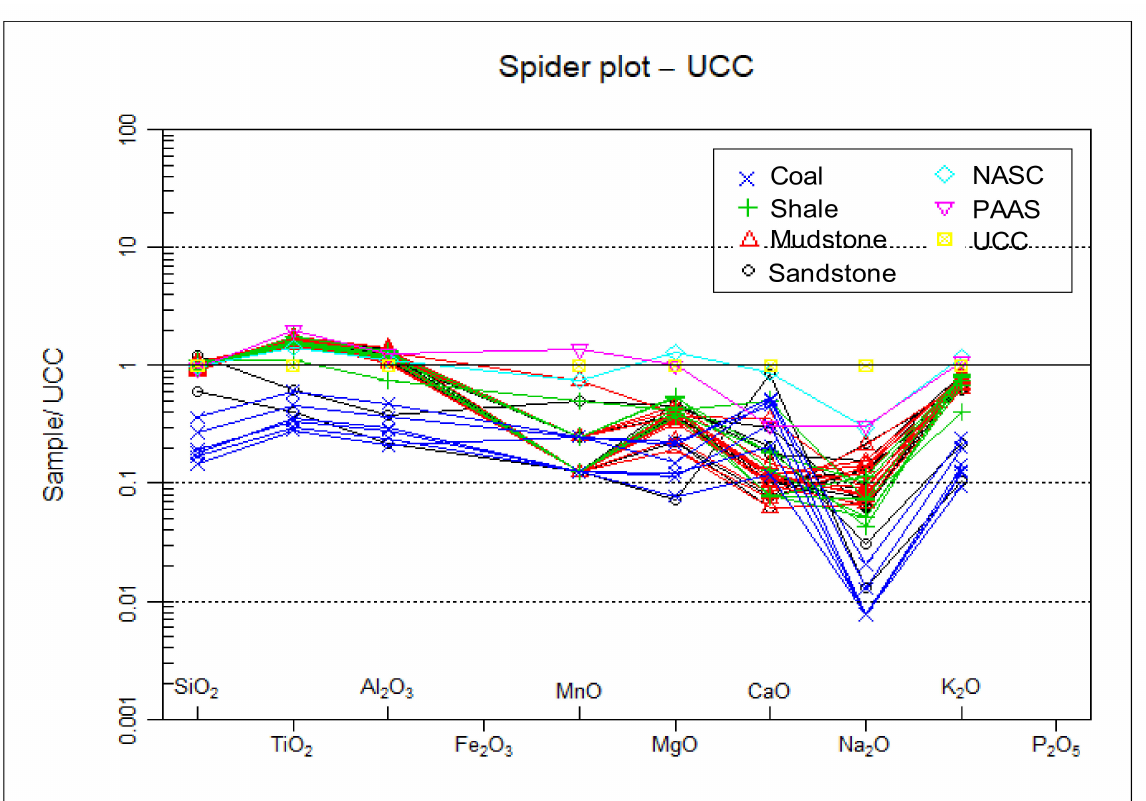
Figure 8. Multivariation diagram of oxides for the studied samples normalized against UCC (after